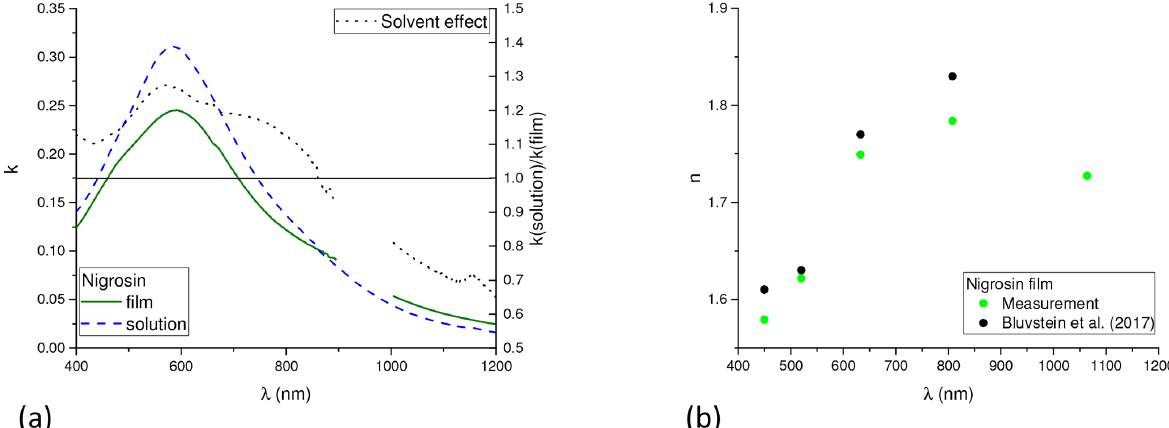
Figure 7. The imaginary part of the refractive index k determined for solid nigrosin film and its aqueous solution (a) . The solvent effect, the ratio of the determined imaginary parts of the refractive index, is marked by the dashed line. The real part of the measured refractive index for nigrosin film compared with the literature data (b)